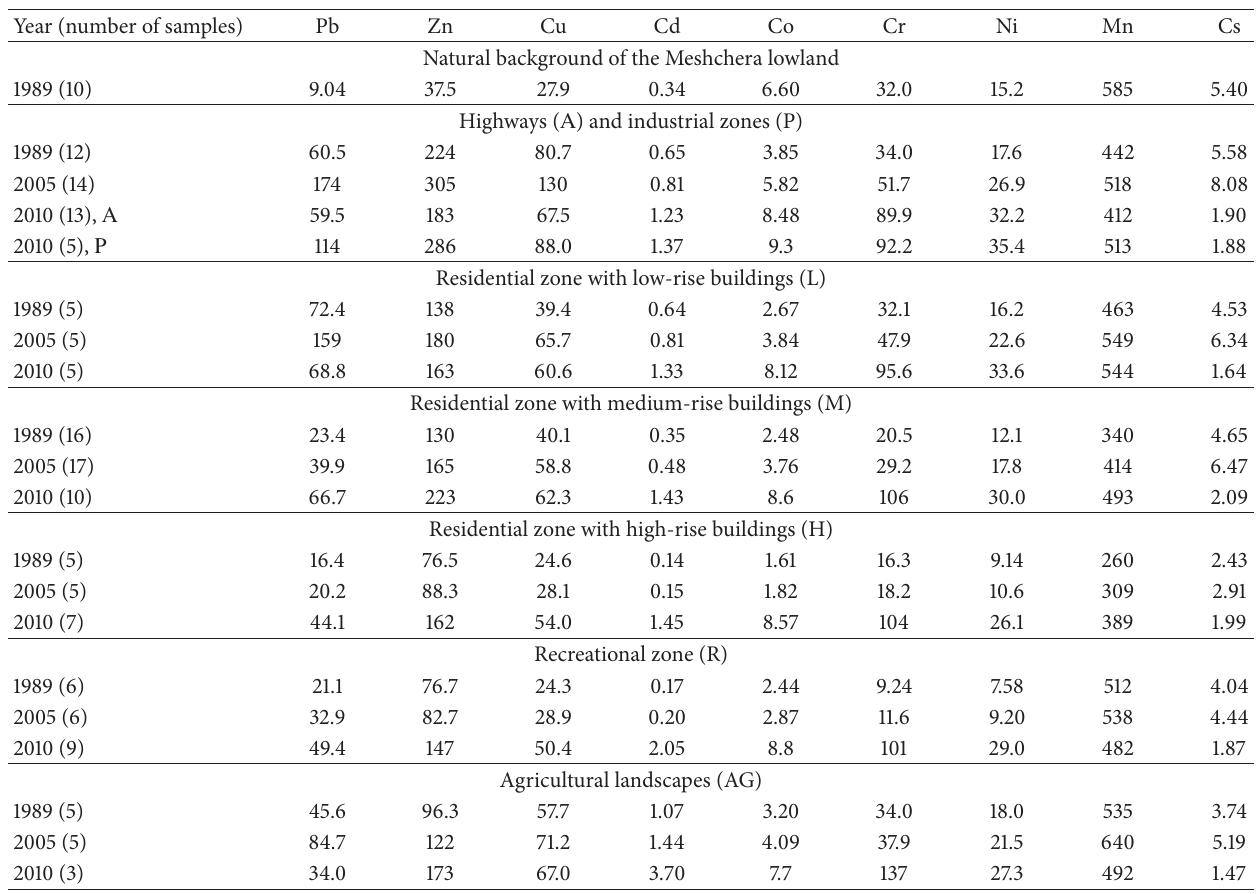
Table 2: Mean content of HMs (mg/kg) in topsoils of natural background and various land-use zones in the Eastern district of Moscow in 1989, 2005, and